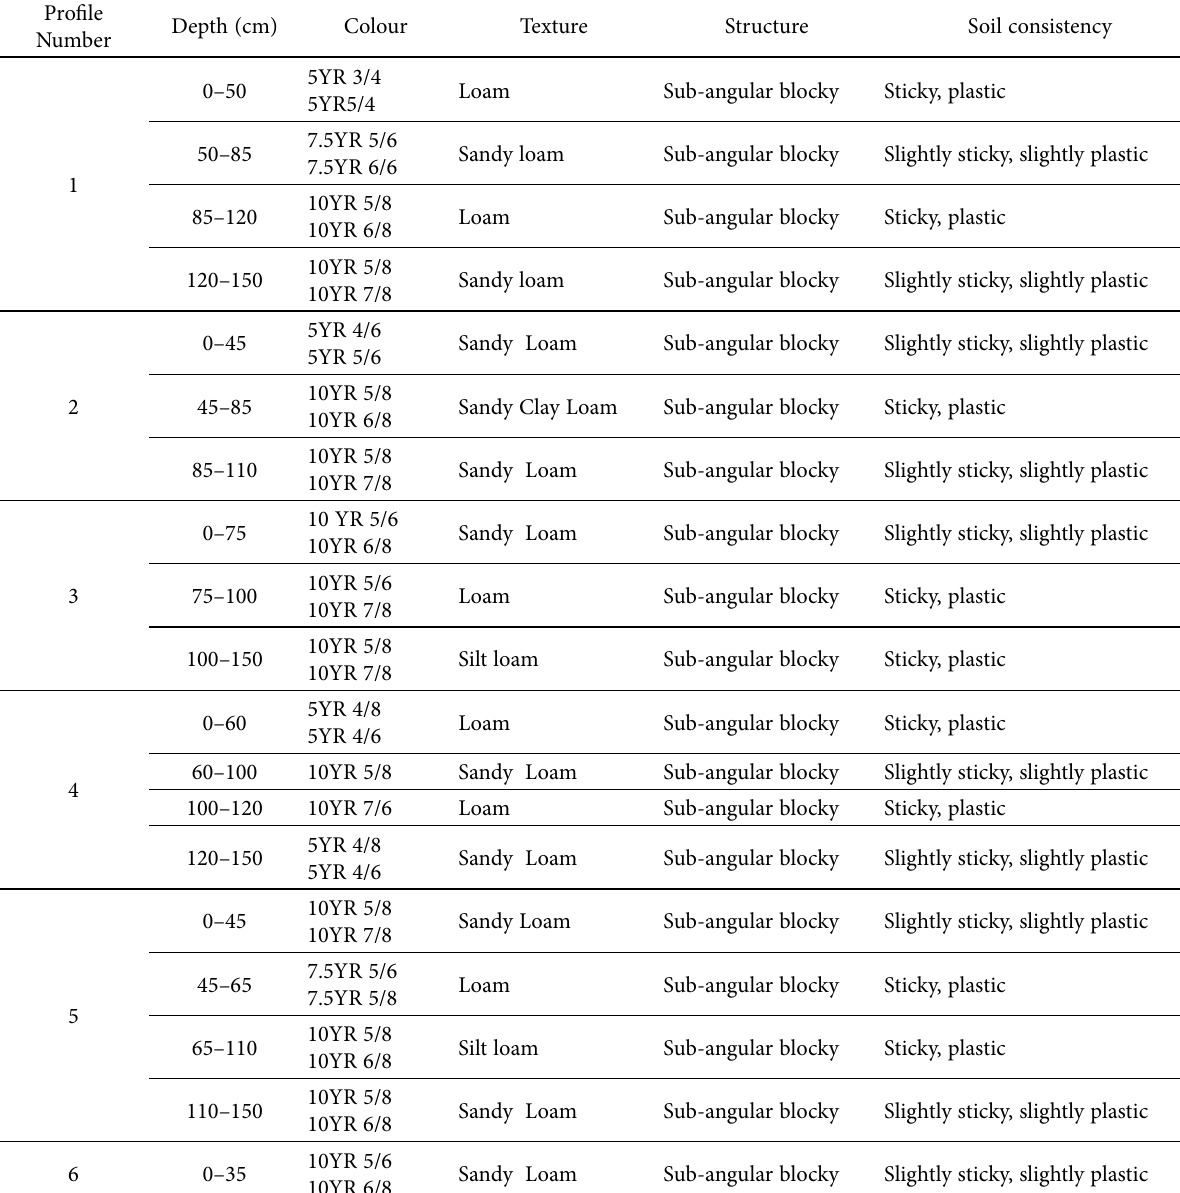
Table 2. Pedological descriptions of soil